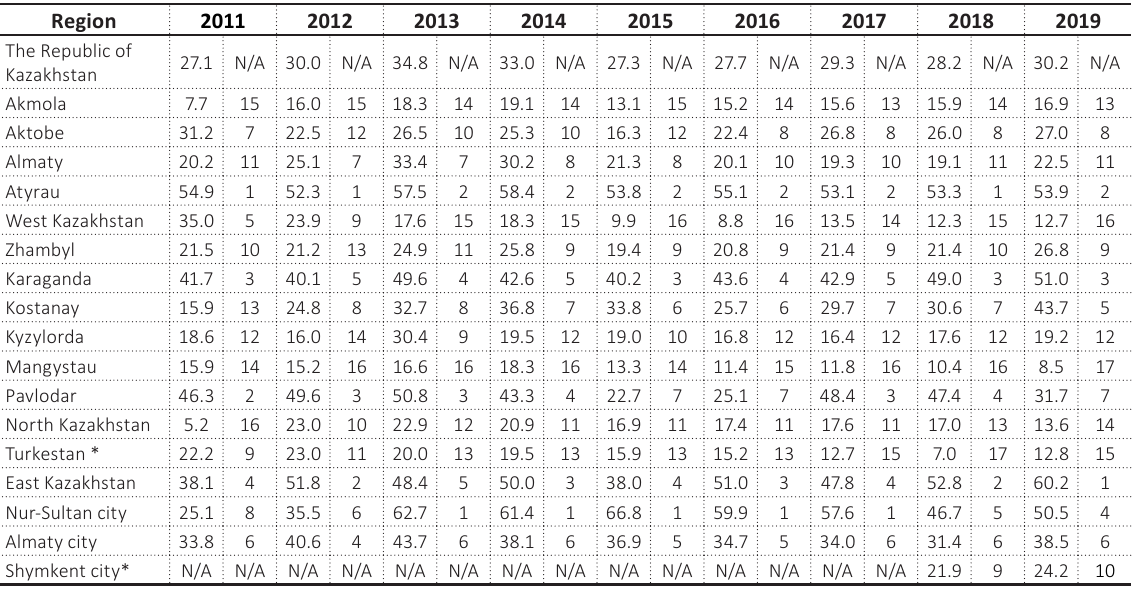
Table A2. Index and ranking of economic development of Kazakhstani regions, 2011–2019 Region